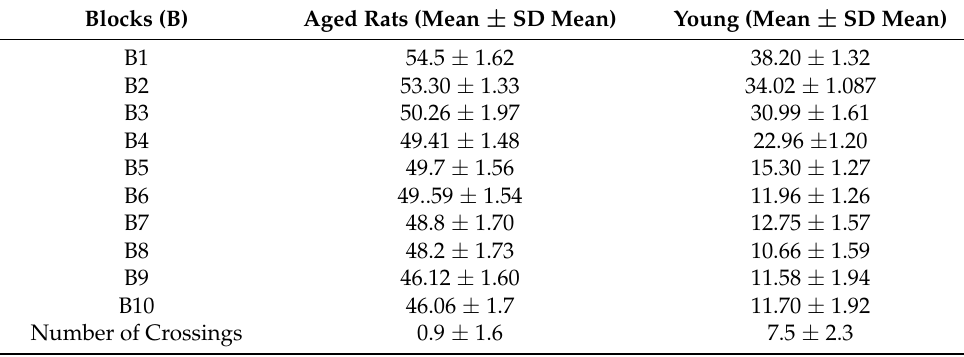
Table 2. Data (mean ± SD mean) corresponding to biochemical indicators in examined brain areas between experimental groups.